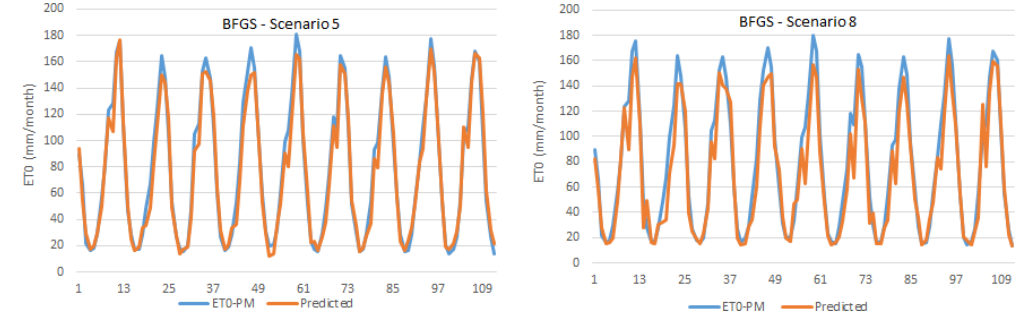
Figure 9. Time series graphics of BFGS-ANN-estimated and FAO56PM-estimated ET 0 in scenarios 5 and 8. Table 5. Outcomes of the SVR modelling approach from different kernel functions based on R 2 , MAE, and RMSE (italic font represents the best results; bold represents the optimally selected